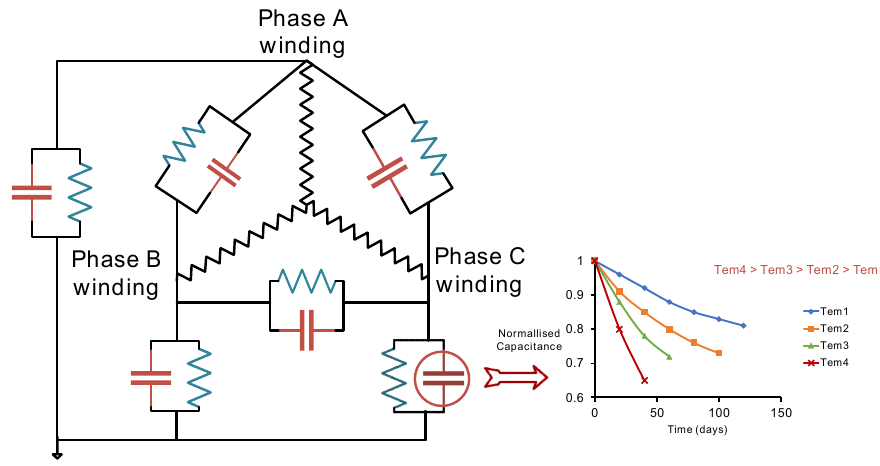
Figure 2. Equivalent circuit of the stator winding insulation. Data from [14].